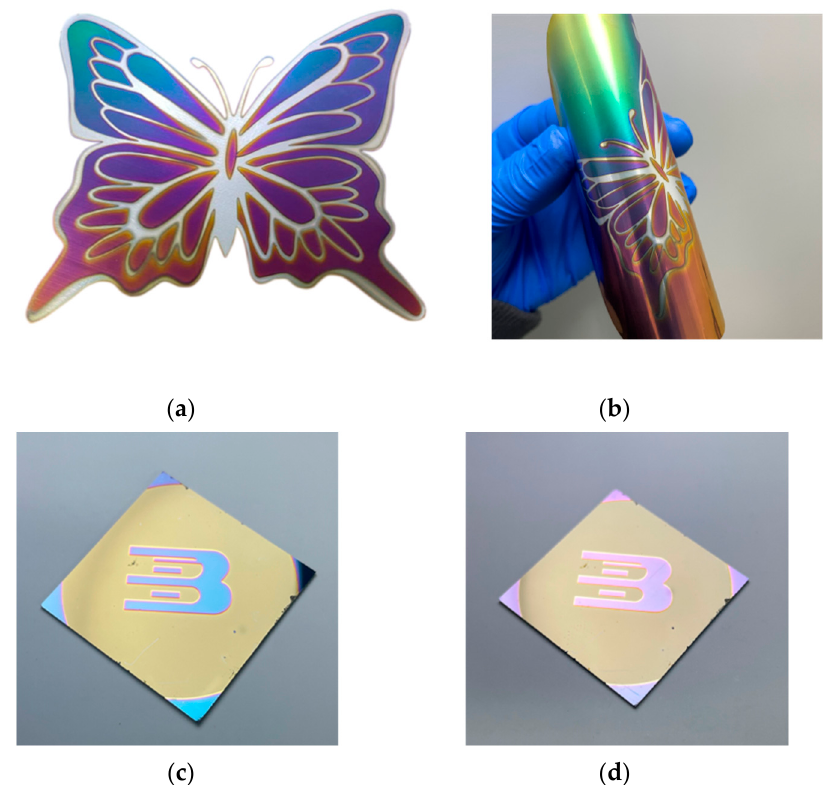
Figure 11. ( a ) Color “butterfly” image of flexible structure made on pet substrate; ( b ) flexibility test (that is, when the film is bent, the color in the bent region is not dramatically different). Optical images of amorphous ( c ) and crystalline ( d ) reflective structural color filters on Si.